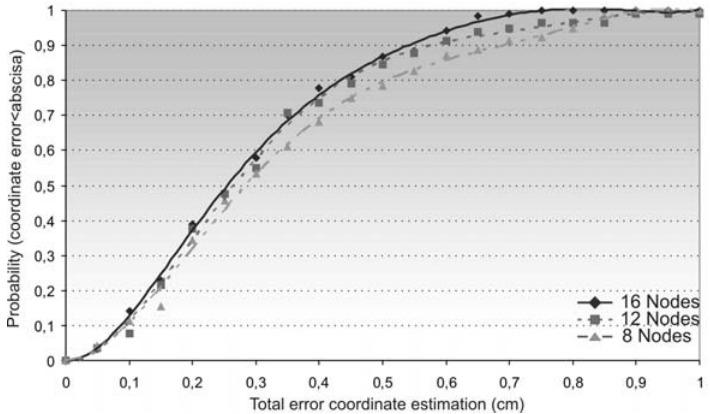
Figure 6. Cumulative distribution function in the position estimation of node N on the total number of nodes (8, 12 and 16), and for a Gaussian error in the pTOF measurements of σ = 10